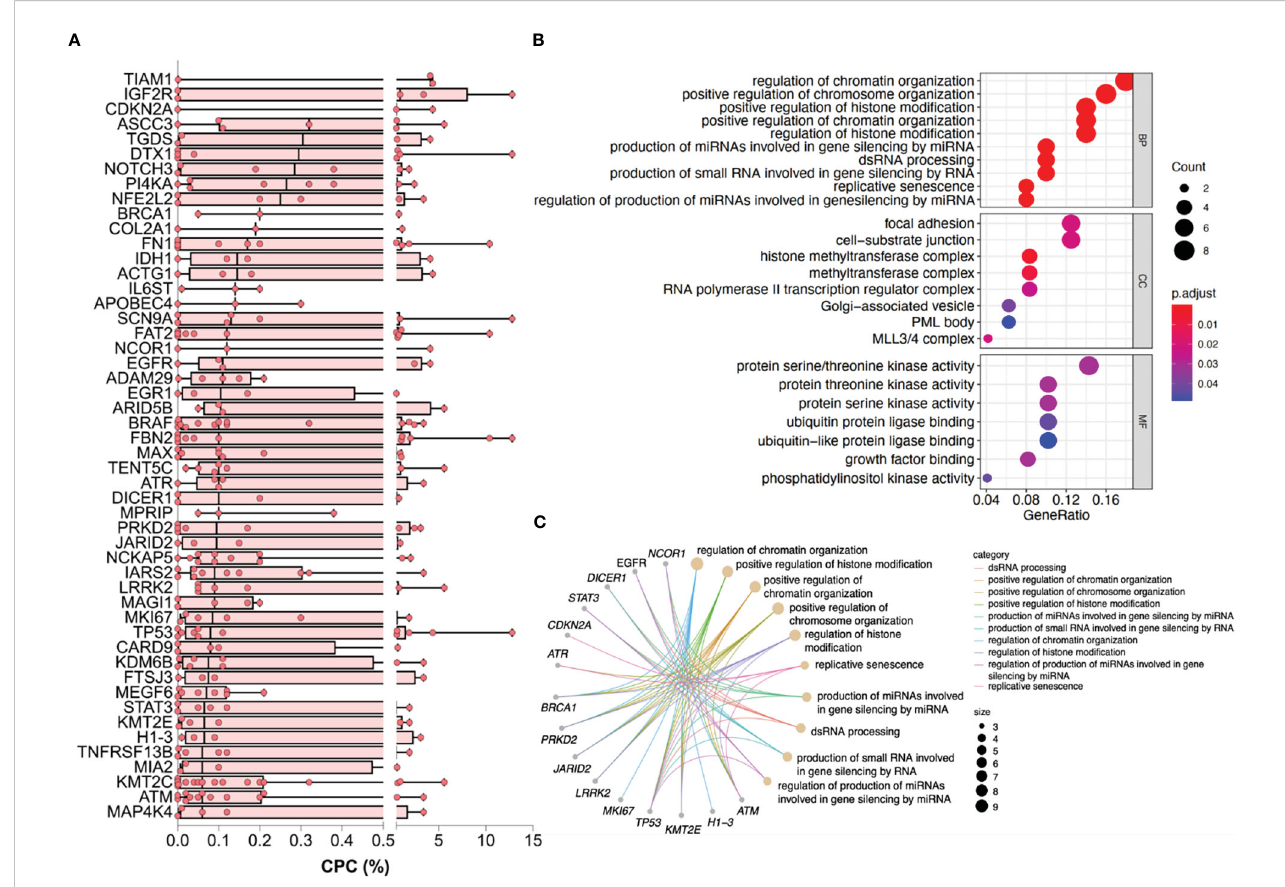
FIGURE 4 Genes and enriched pathways associated with higher CPC levels. (A) The top 50 genes with the highest CPC levels. (B) Dotplot re fl ecting top terms in GO enrichment. (C) Cnetplot of pathway-gene network for the top 10 terms of GO enrichment and relevant genes. CPC, circulating plasma cells; GO, Gene